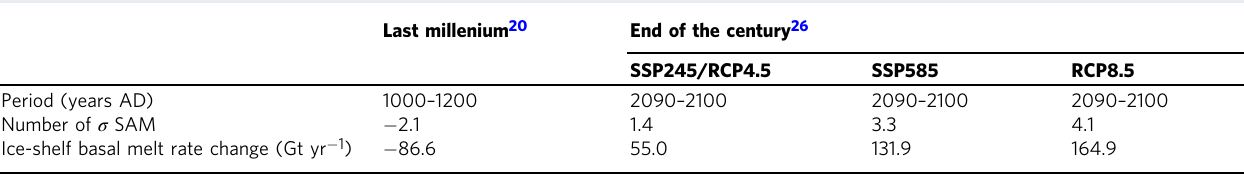
Table 2 Estimates of ice-shelf basal melt rate changes in the past and